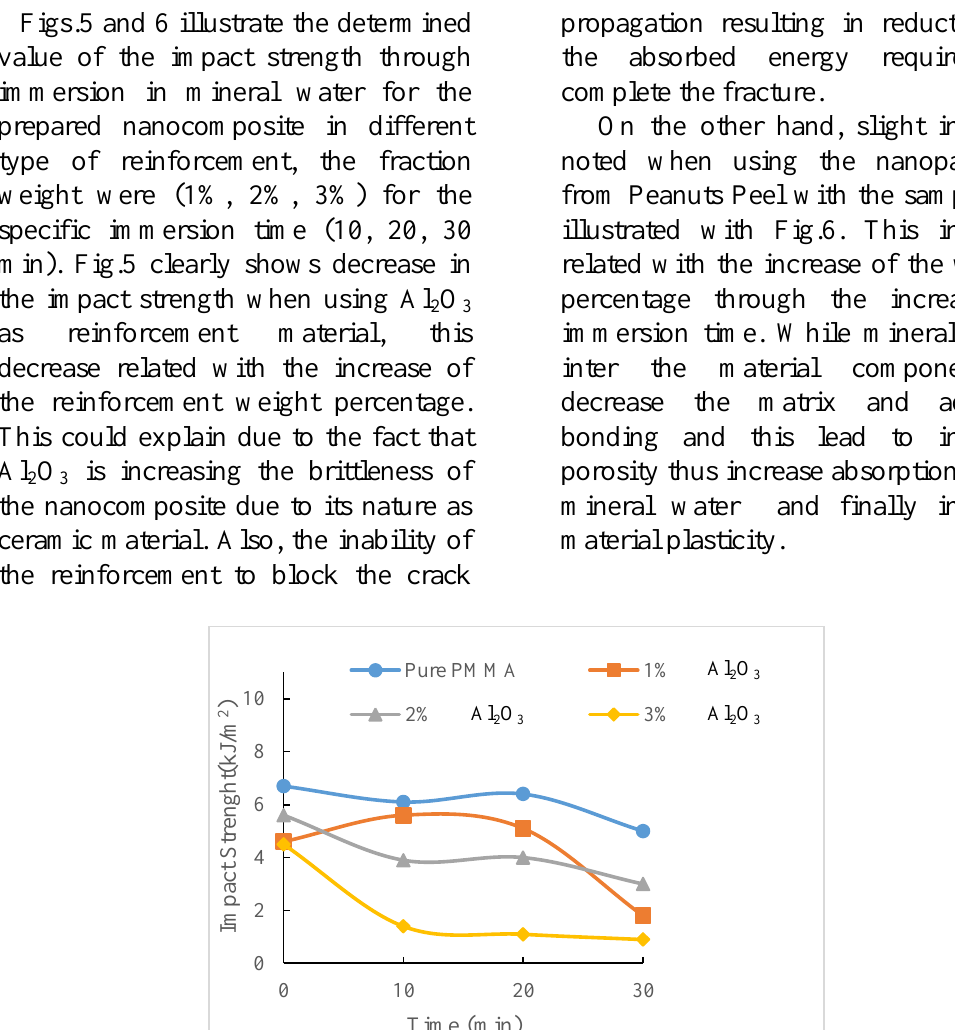
O ) in mineral 2 3